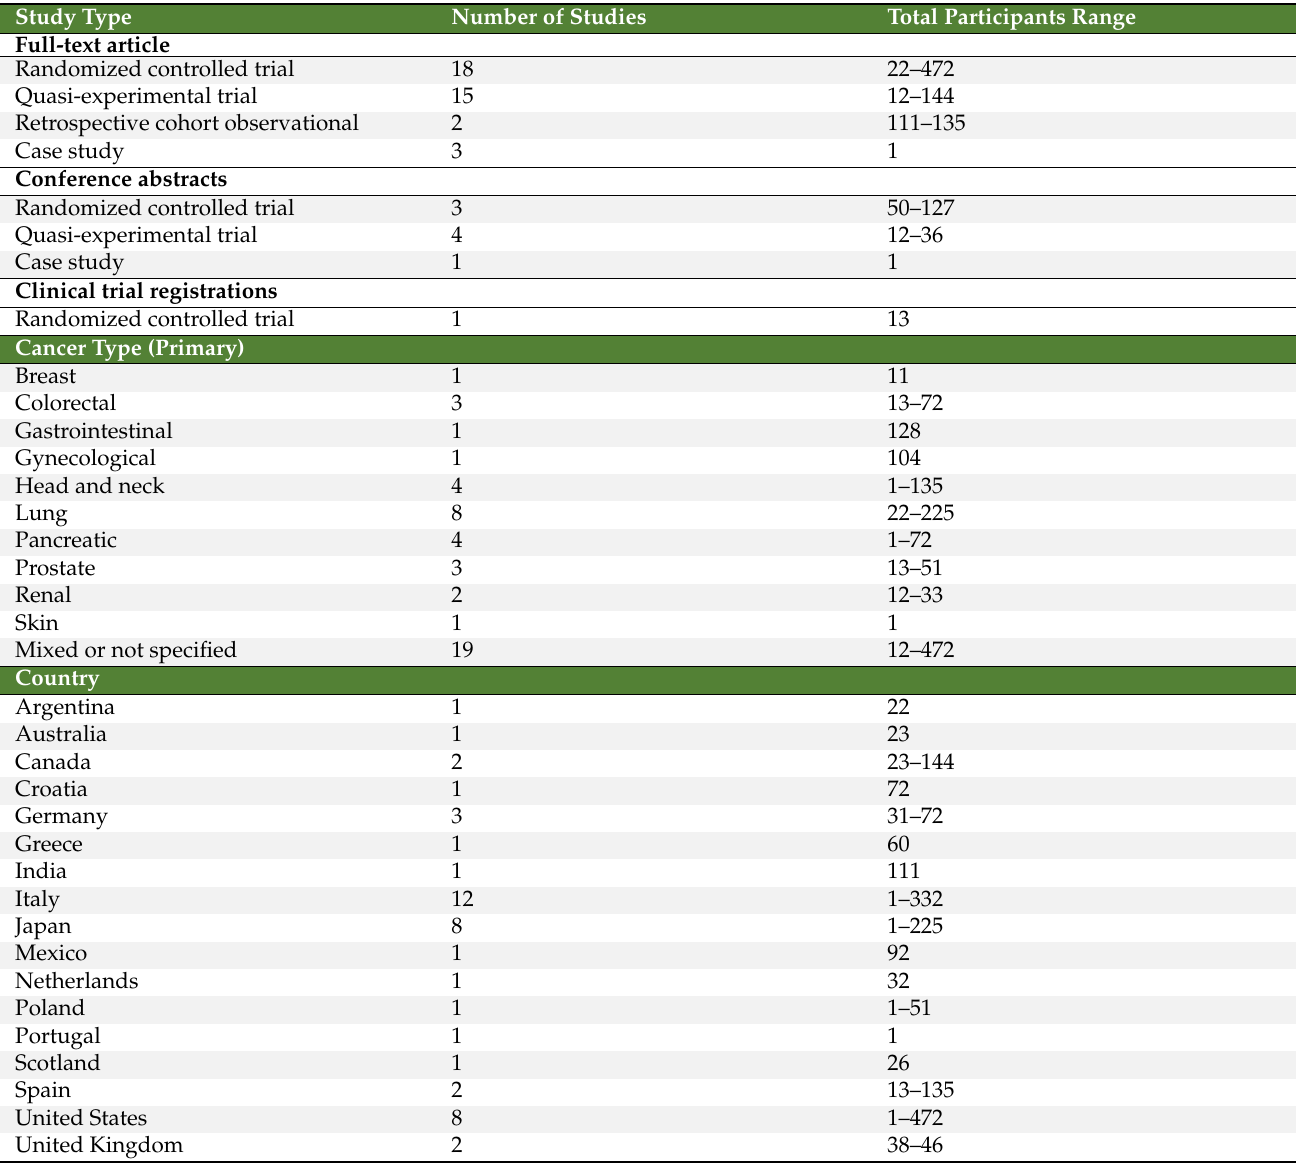
Table 2. Number of completed studies (excluding one clinical trial registration which has not started recruitment) and number of participants included, according to study type, cancer type, and